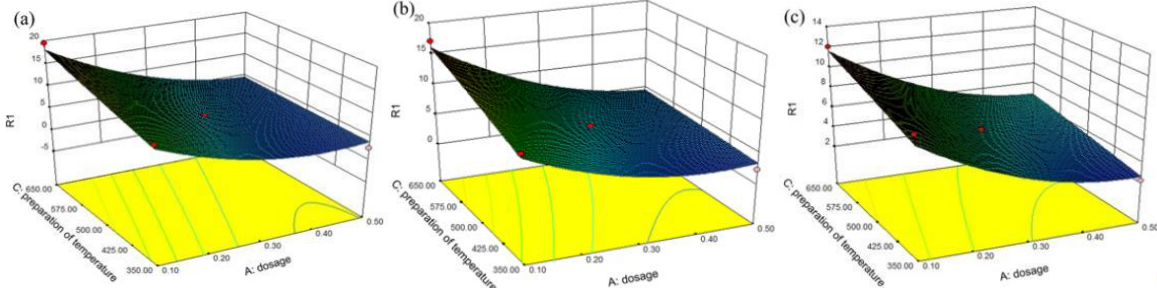
Table 7. Analysis of variance of the regression equation for cadmium ion adsorption by three bi- oches.